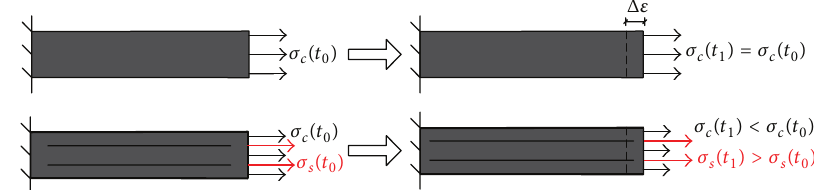
Figure 2: Effect of reinforcement on concrete stress in creep tests ( 𝜎 𝑐 : concrete stress; 𝜎 𝑠 : reinforcement stress).